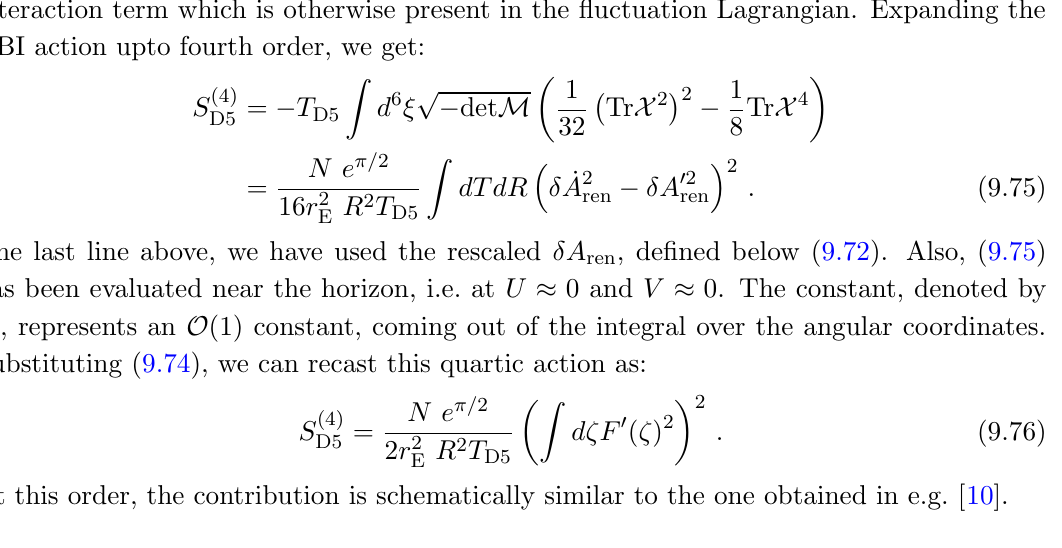
Figure 5 . A Penrose diagram representation of the 2 (cid:0) 2 elastic scattering which is used to calculate the phase shift. This is identical to the discussion in [7]. The Kruskal extension was obtained in [39]. (cid:0) (cid:1) to zero and also set Tr X = Tr M (cid:0) 1 (cid:14) M = 0. The last condition eliminates a